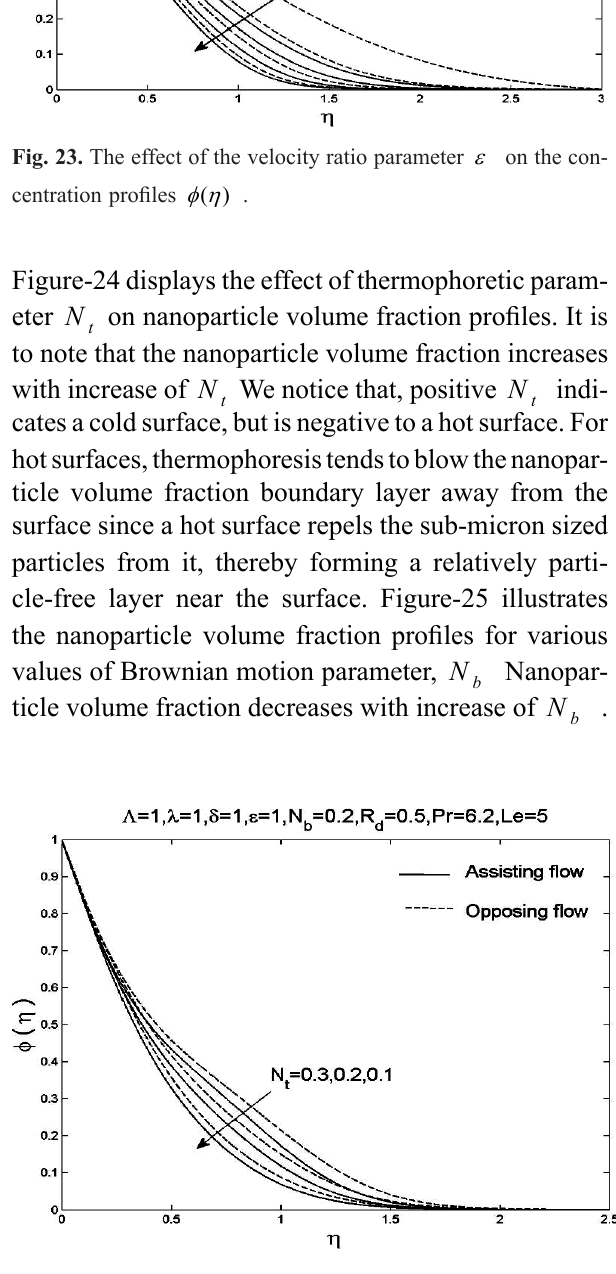
Fig. 23. The effect of the velocity ratio parameter ε on the con- centration profiles ( ) φη .